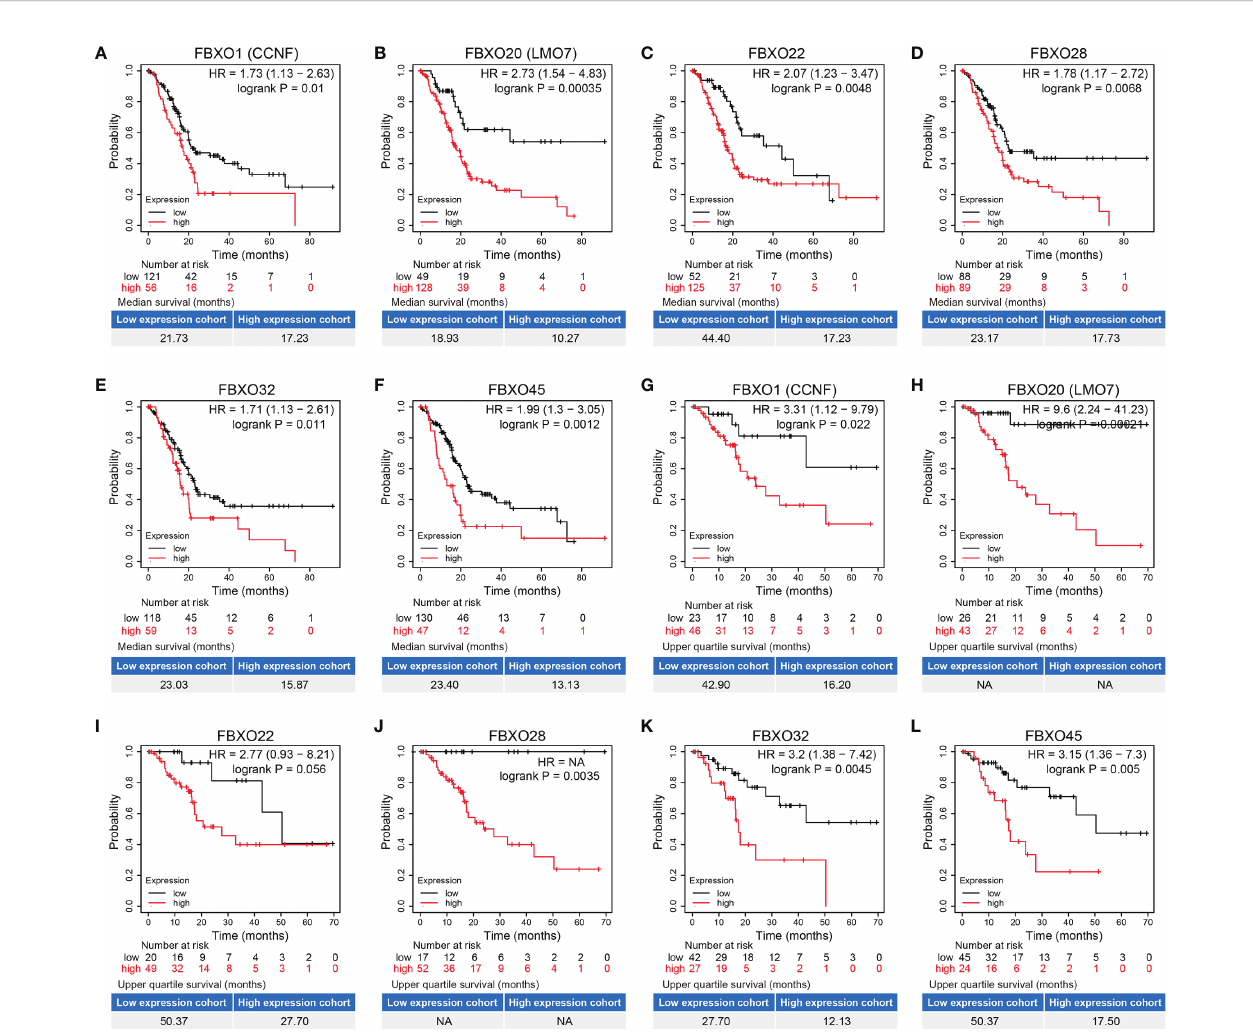
FIGURE 5 | The prognostic analysis of the six-FBXOs in pancreatic ductal adenocarcinoma (PDAC) using Kaplan – Meier plotter. (A – F) The overall survival of the six- FBXOs in PDAC patients ( N = 177). (G – L) The disease-free survival of the six-FBXOs in PDAC patients ( N = 69). “ Auto-select best cutoff ” was selected. NA, not